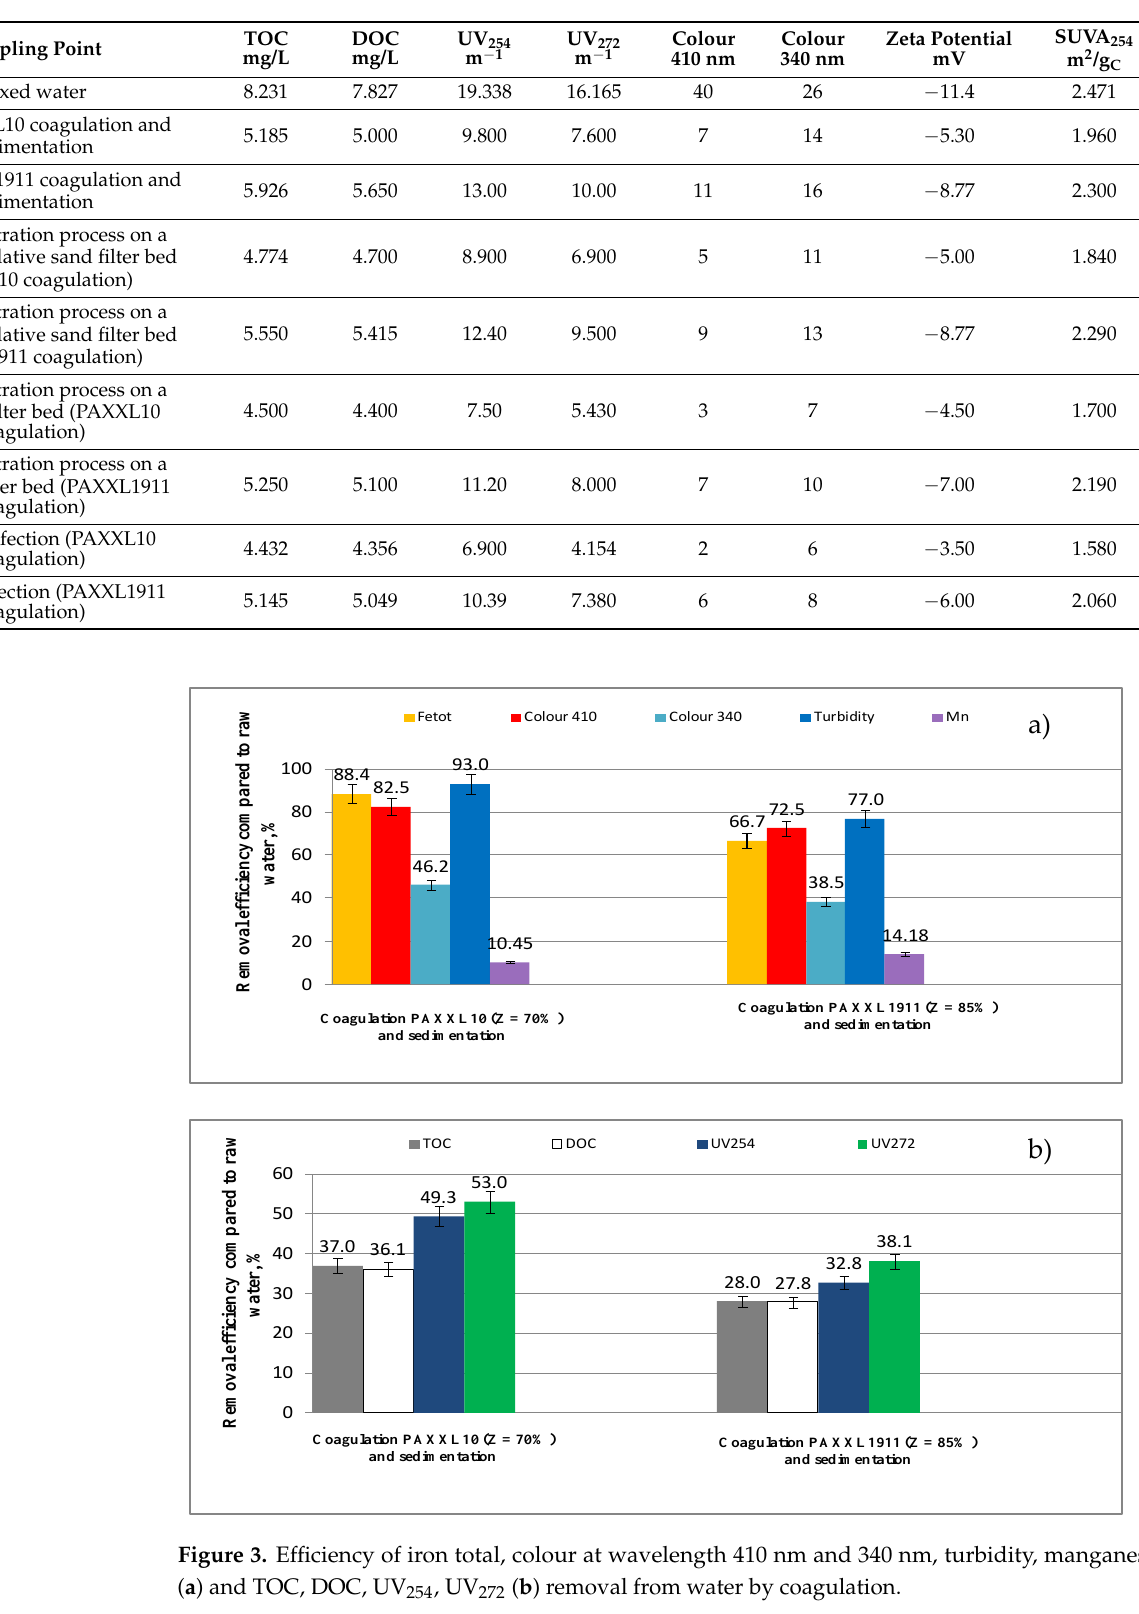
Table 3. Contents of organic substances, color, and value of Zeta potential and SUVA 254 indicator in water after individual stages of its treatment.